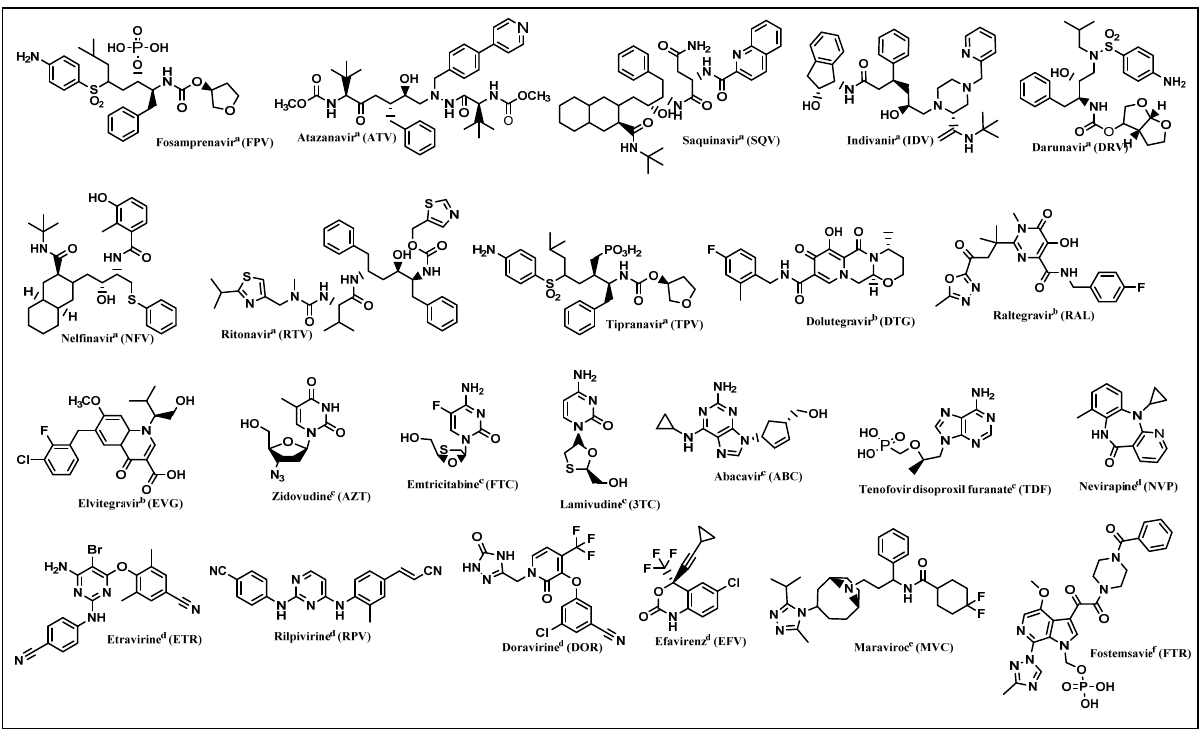
Figure 3. ART drugs approved by the FDA (a = PIs, b = INSTIs, c = NRTIs, d = NNRTIs, e = CCR5 receptor antagonist, f = post-attachment inhibitors). Table 1. List of cART medicines approved by the FDA for the treatment of HIV infections.